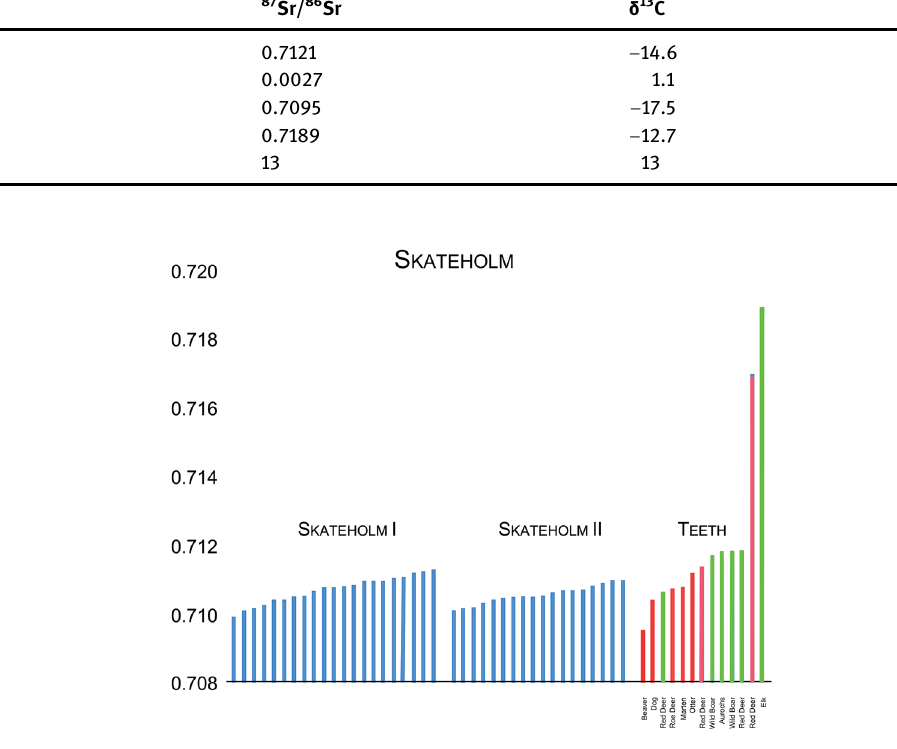
Figure 3: Ranked bar graphs of 87 Sr/ 86 Sr values for two groups of human burials, blue bars, for Skateholm I and II, and the teeth. Red bars are teeth from refuse, green bars are tooth beads from